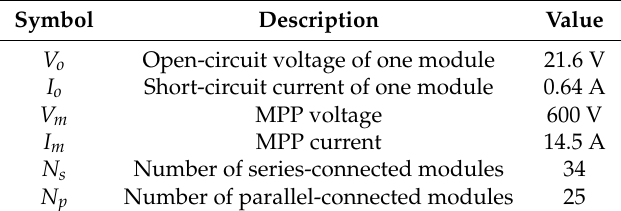
Table 1. Design parameters of Solar PV